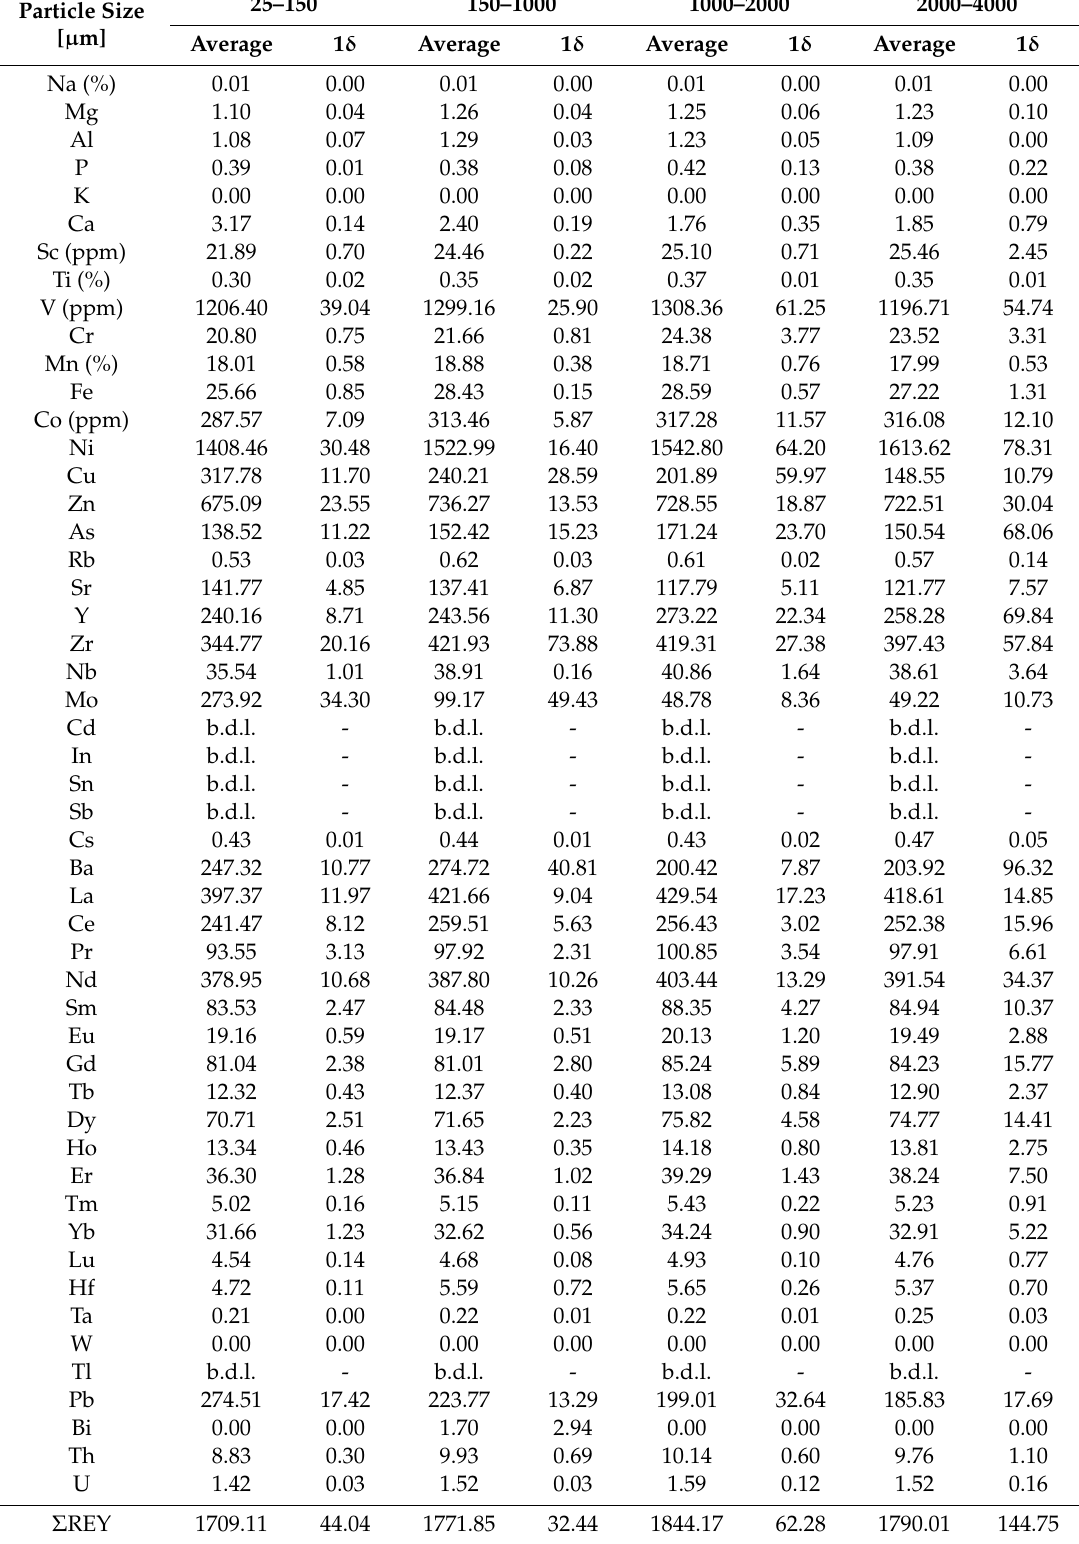
Table 1. Chemical composition of the Kunimiyama umber determined by